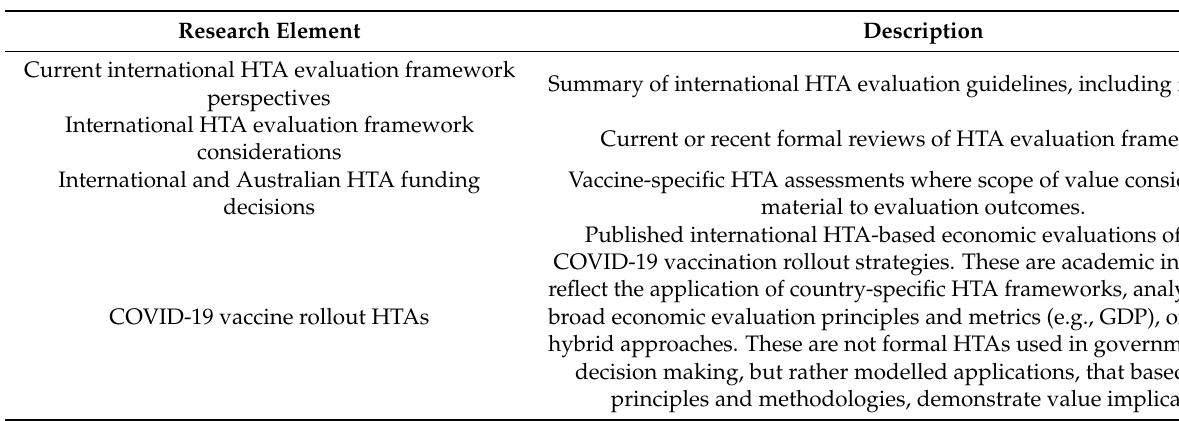
Table 1. Summary of literature search approach.